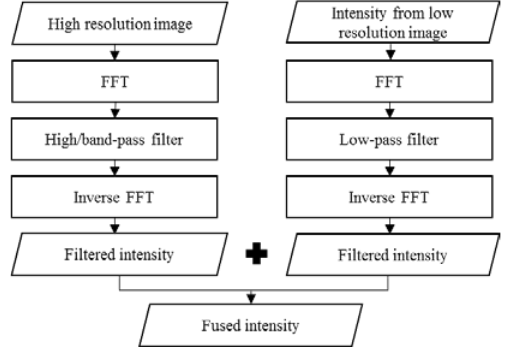
Figure 5. Intensity enhancement procedure (based on the flowchart from Klonus and Ehlers (2007)